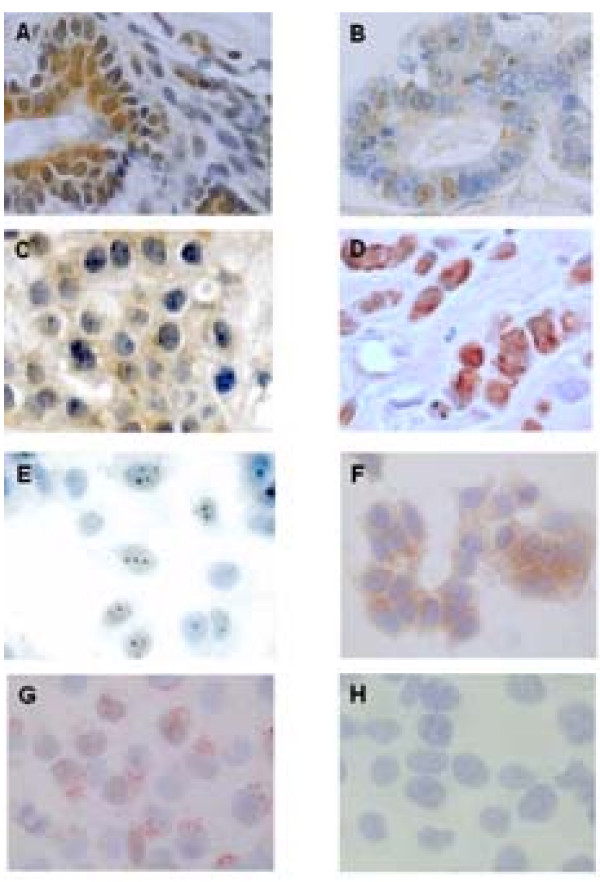
HEX expression and localization in normal tissues, breast carcinomas and cell lines. Immunohistochemical analysis was performed as described in the methods section. A and B: normal breast tissue. C: ductal carcinoma. D: lobular carcinoma. E: MCF-7 cells. F: T47D cells. G: HBL100 cells stained with p63 and CD10. H: HBL100 cells stained with HEX.